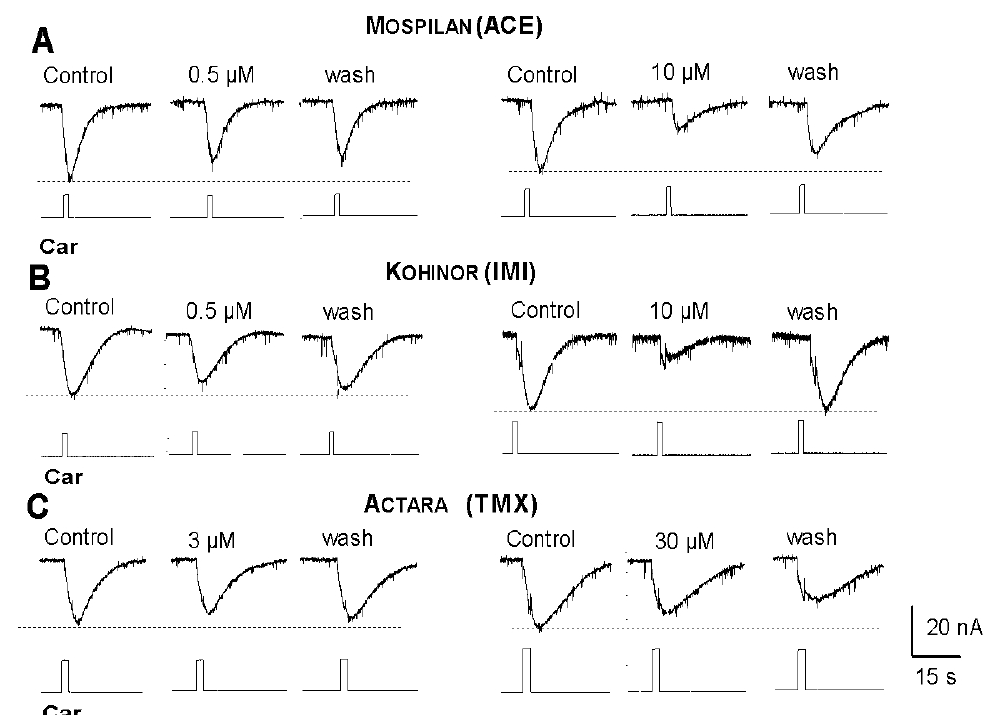
Figure 10. Inhibitory e ff ects of neonicotinoids on ACh-evoked inward currents by M ospilan ( A ), K ohinor ( B ) and A ctara ( C ). Concentration values are expressed in molarities of the active components of the individual insecticides.